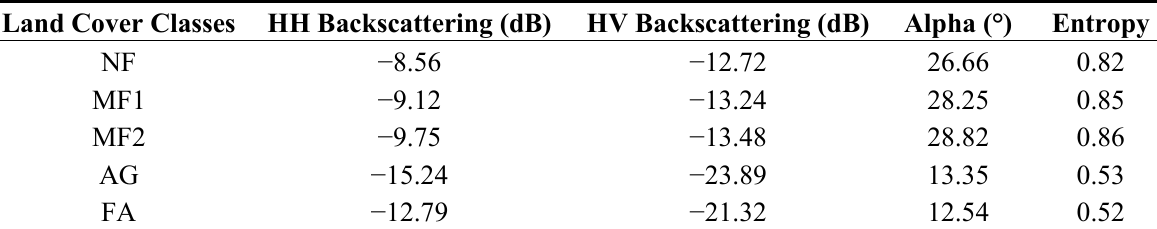
Table 6. Average values of the intensity backscattering at HH, HV, alpha and entropy for different land cover classes. The results are based on the training dataset. See Table 1 for the descriptions of